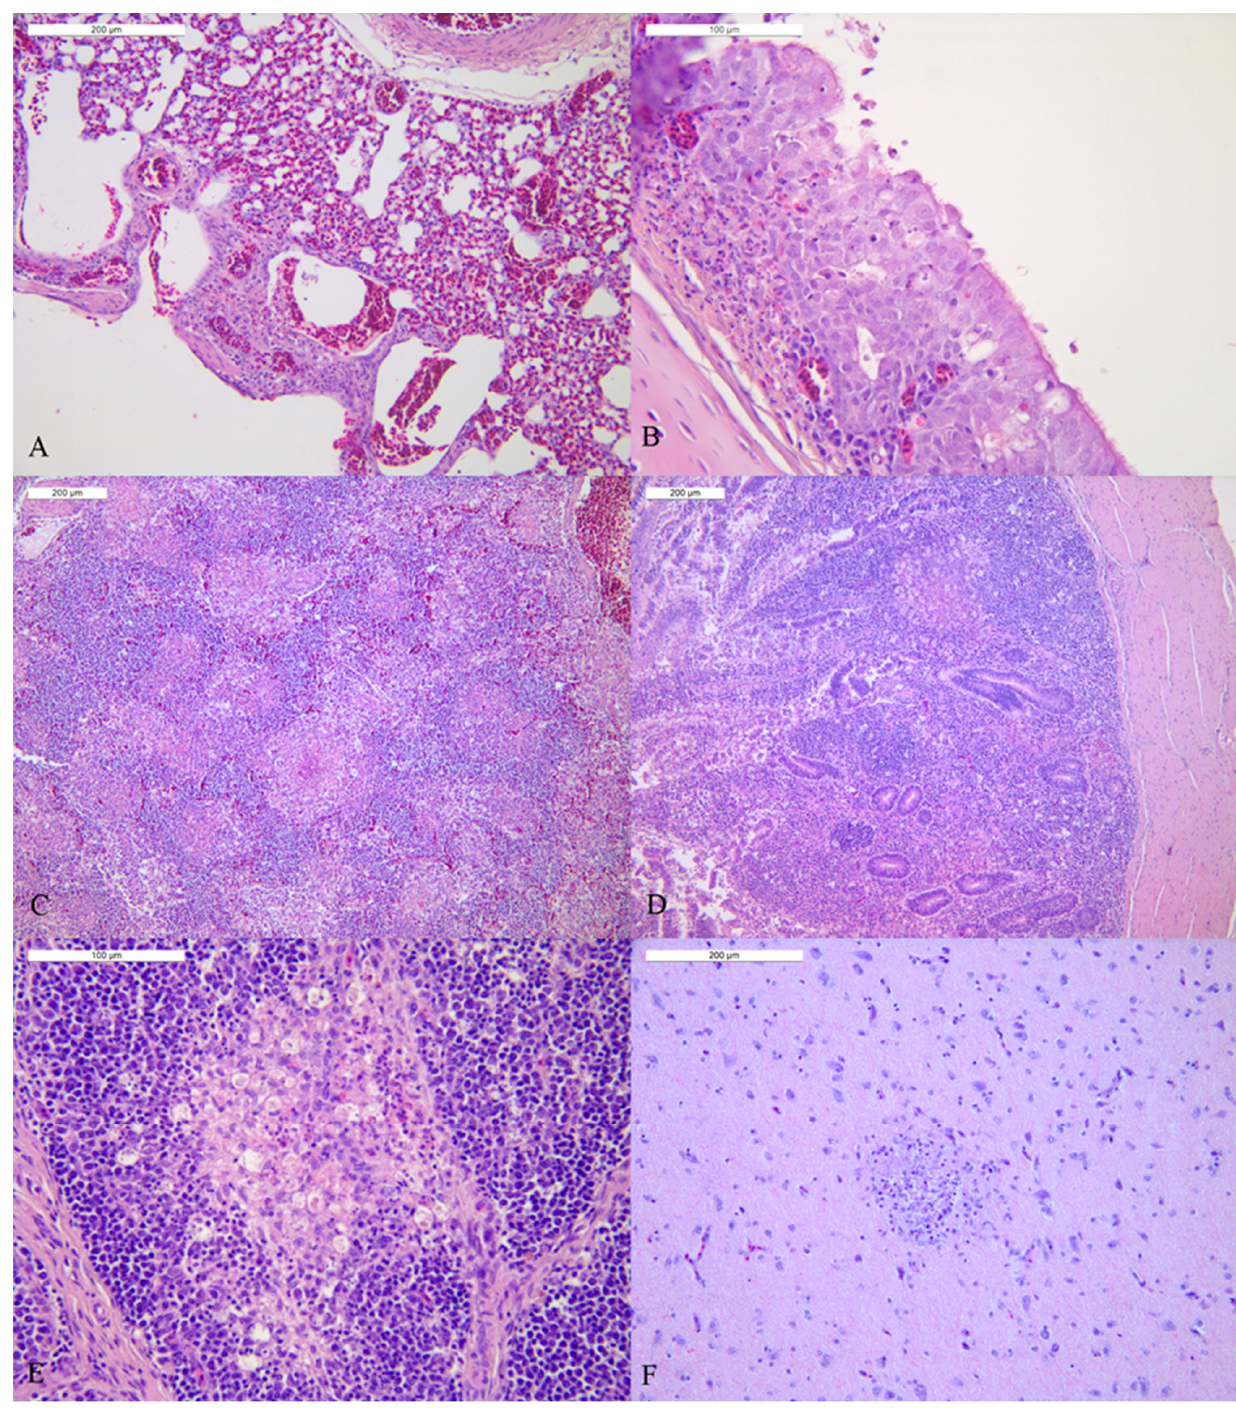
Figure 5. Histopathology of organs of broiler of house 1 (HE): ( A ) Lung: congestion of the parenchyma and small necrotic parabronchial area admixed with few heterophils. ( B ) Trachea: foci of necrosis admixed with heterophils and few lymphoplasmacells. ( C ) Spleen: severe multifocal to coalescing necrosis with heterophilic infiltration. ( D ) Cecal tonsils: multifocal necrosis of the mucosa admixed with heterophils and diffuse lymphoplasmacytic infiltration of the lamina propria . ( E ) Bursa of Fabricius : focal depletion of lymphocytes in the medulla with necrosis and heterophils, ( F ) brain: focal necrosis with activated microglial cells.